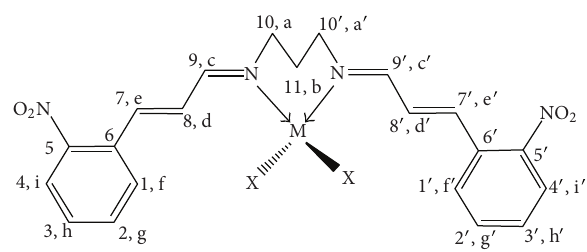
F 1: e structure of ligand and